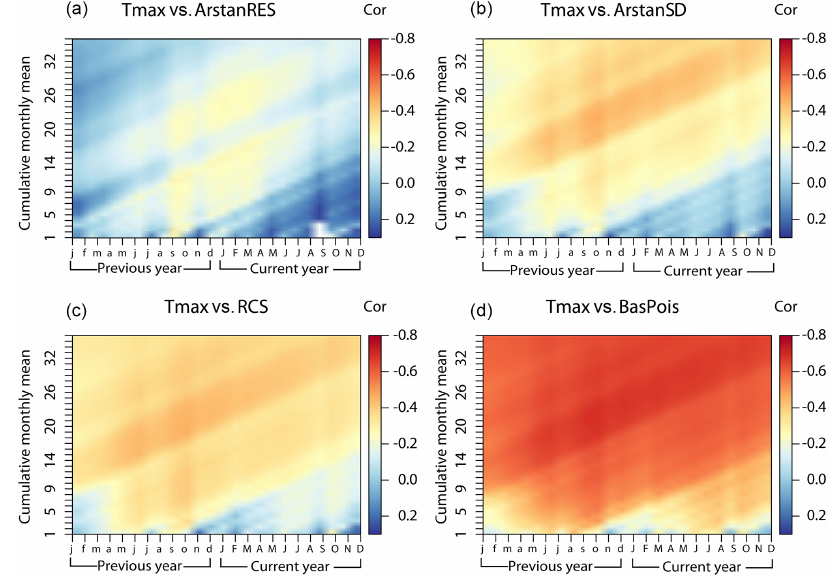
Figure 5. Correlation between the monthly mean of daily maximum temperature (from January of the previous year to December of the cur- rent year with a cumulative monthly mean from 1 to 36 months) and the residual Arstan chronology (a) , the standard Arstan chronology (b) , the RCS standard chronology (c) , and the basal-area Poisson standard chronology (d) .